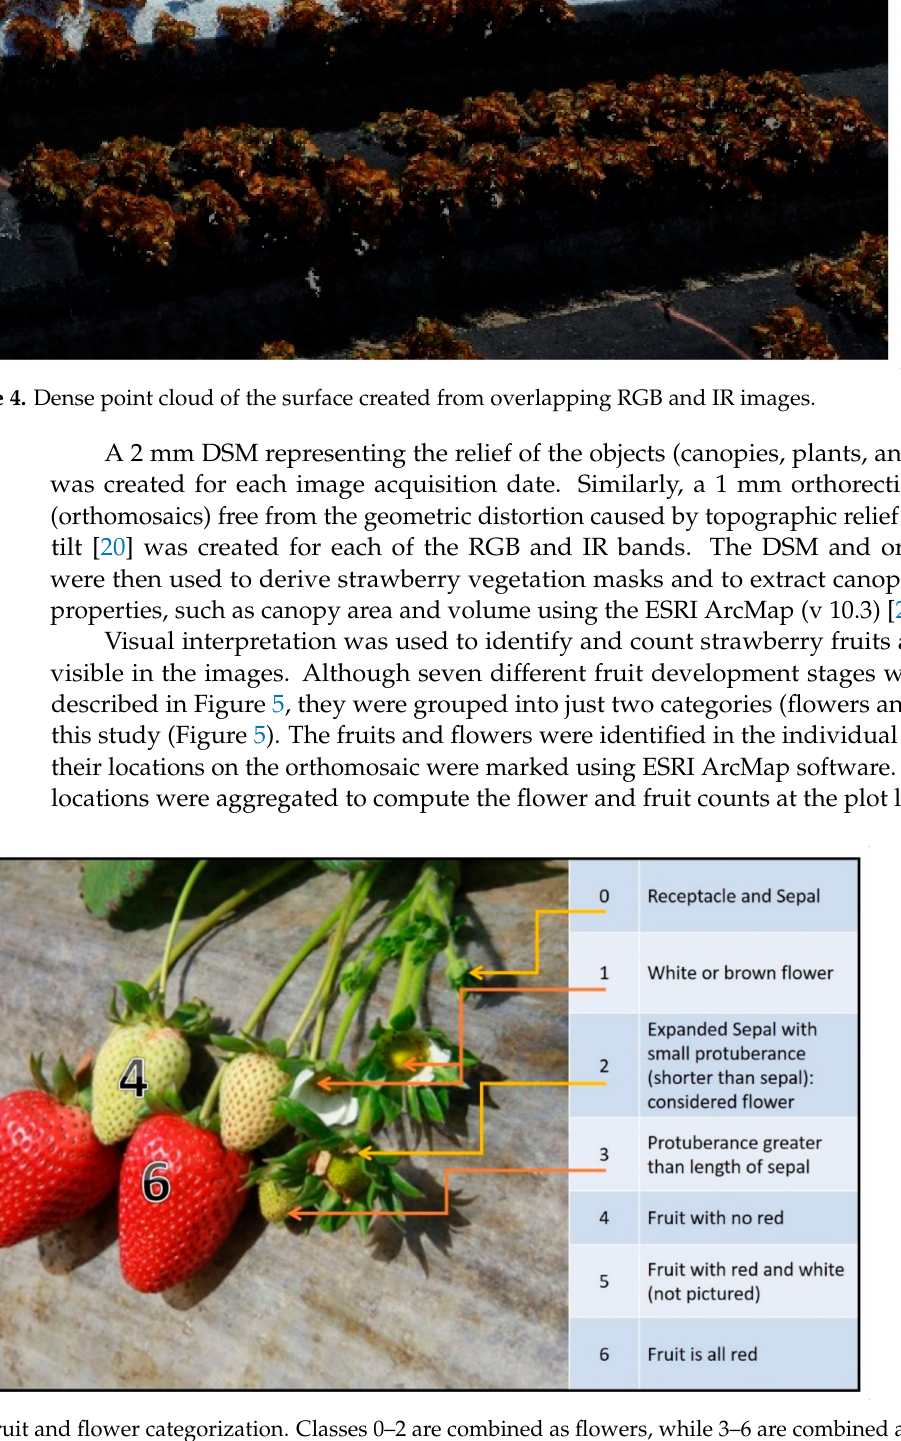
Figure 5. Strawberry fruit and flower categorization. Classes 0–2 are combined as flowers, while 3–6 are combined as